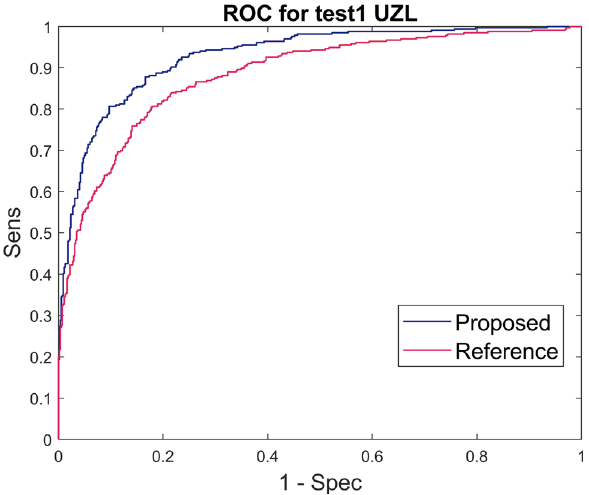
Figure 6. ROC curves for the proposed and reference approaches applied to test1 signals of UZL dataset, exclusively including signals without inter-observer